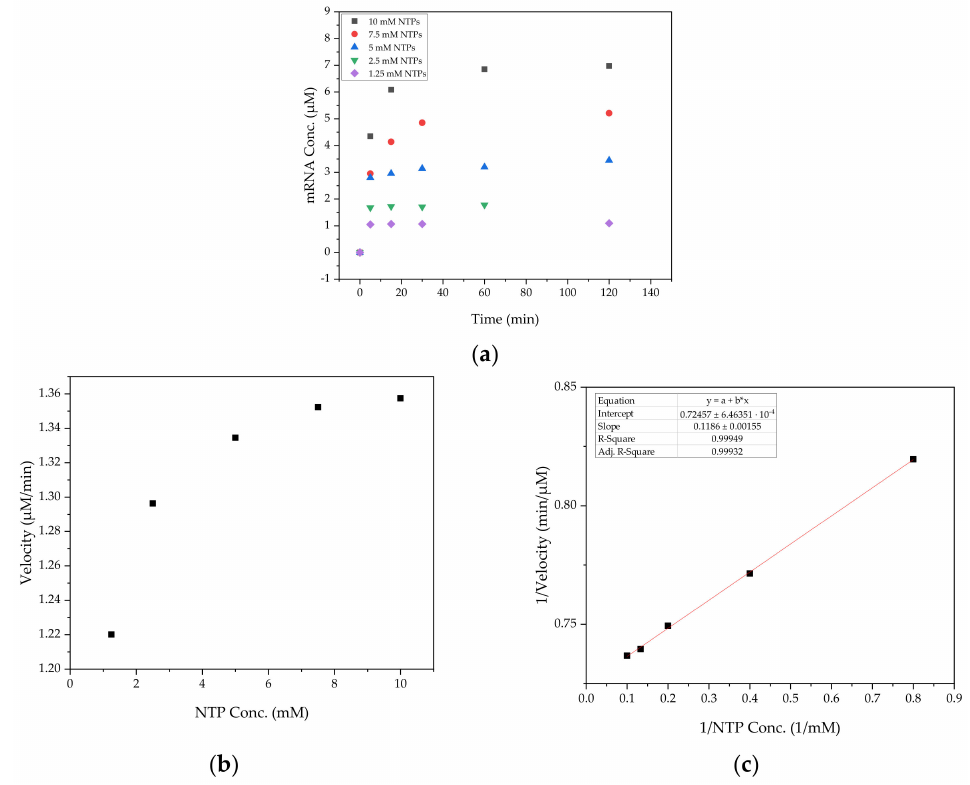
Figure 17. ( a ) Time course of in vitro transcription at different substrate concentrations; ( b ) Michaelis– Menten plot, ( c ) Lineweaver–Burk